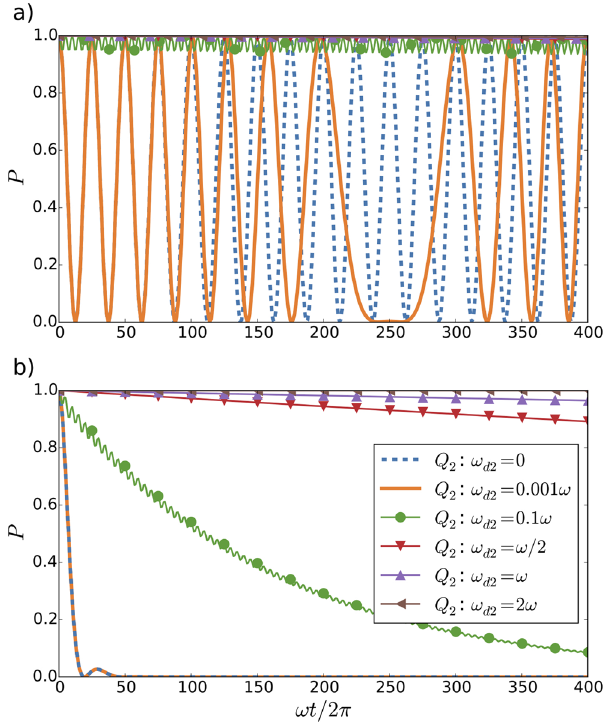
Figure 3. Motion effects in single-atom superradiance, observed in the probability P of excitation of the second qubit Q 2 . We consider the first qubit Q 1 decoupled, g 1 = 0, and the second moving with frequency ω d 2 , for an initial state g e 0 . We show the behaviour for different velocities of the second qubit, ranging from the static 1 2 case, ω d 2 = 0, to a velocity of ω d 2 = 2 ω . For a coupling constant g 2 = 0.02, a qubit decay parameter Γ = 0.002 and T 2 / T 1 = 0.67, we consider two cavity decay rates: ( a ) κ = 0.002, and ( b ) κ = 0.2 (bad-cavity limit), in units of ω